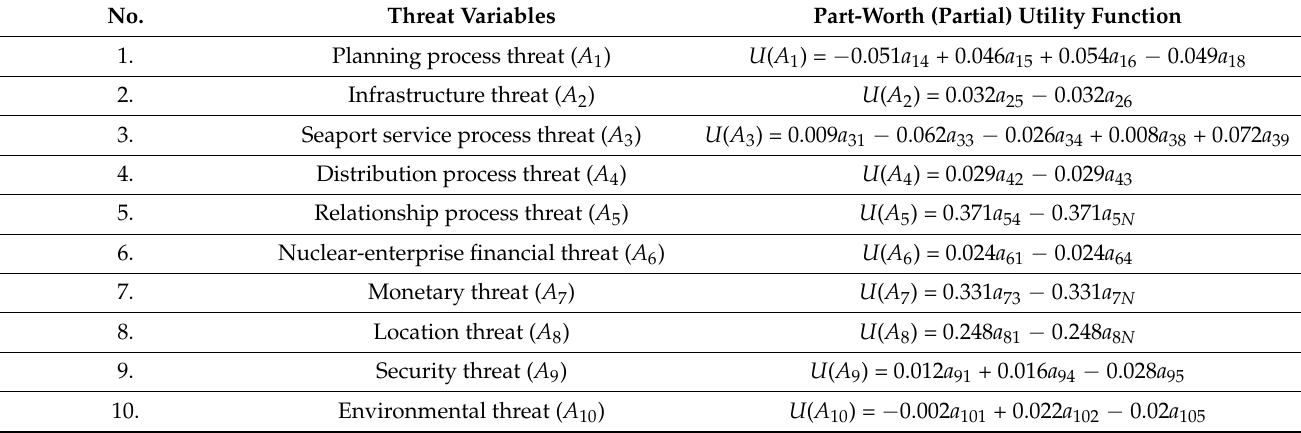
Table 6. Part-worth utility function for seaport risk